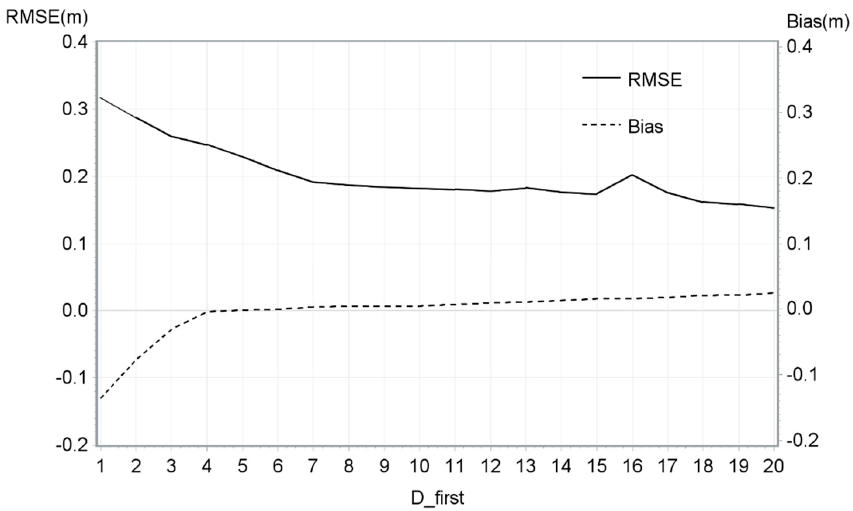
Figure 5. RMSE and mean bias of the DTM model by D_first.